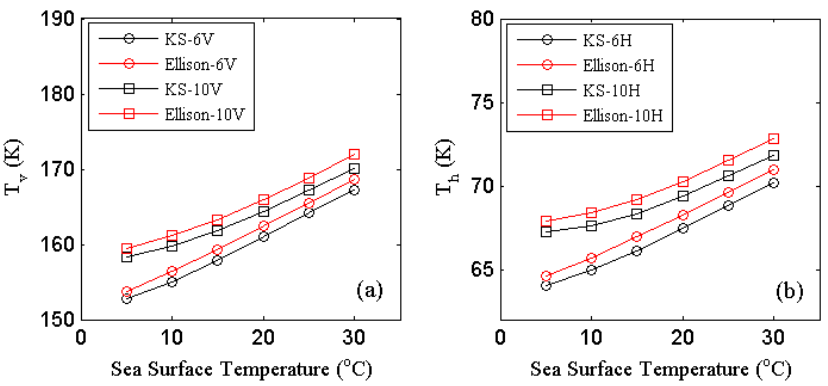
Figure 2. The calculated calm ocean brightness temperatures as a function of sea surface temperature using the Klein-Swift and Ellison models at 6 and 10 GHz channels: ( a ) v-pol; and ( b ) h-pol.